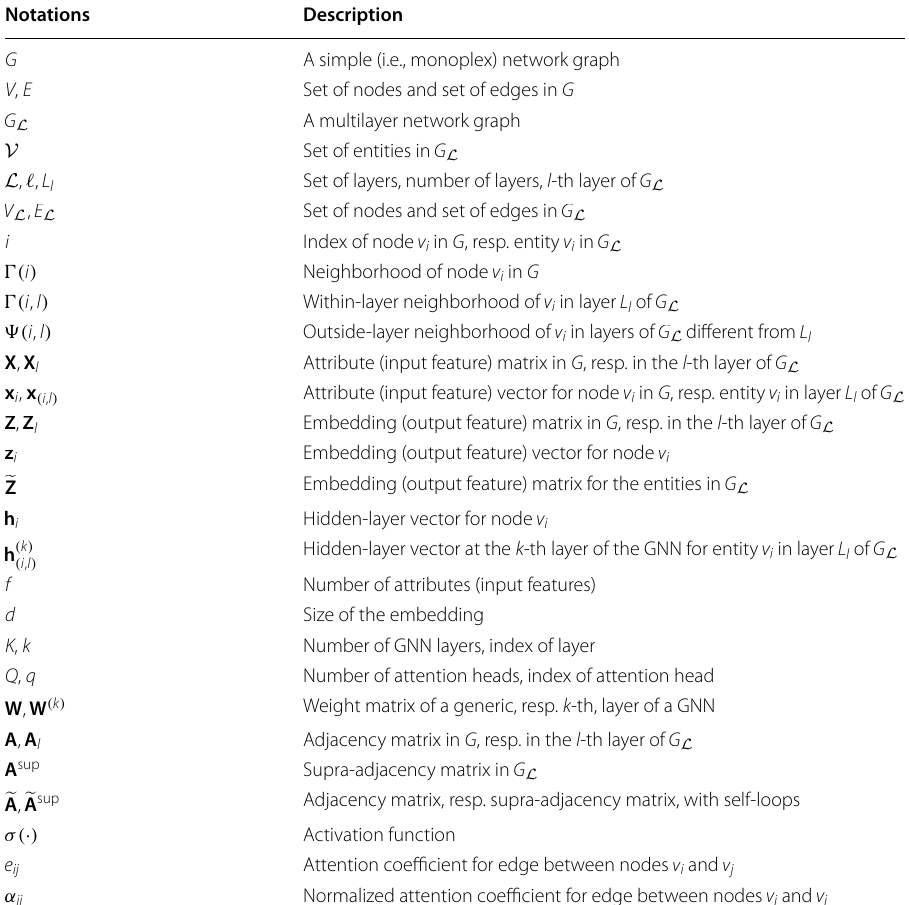
Table 1 Summary of notations and their description